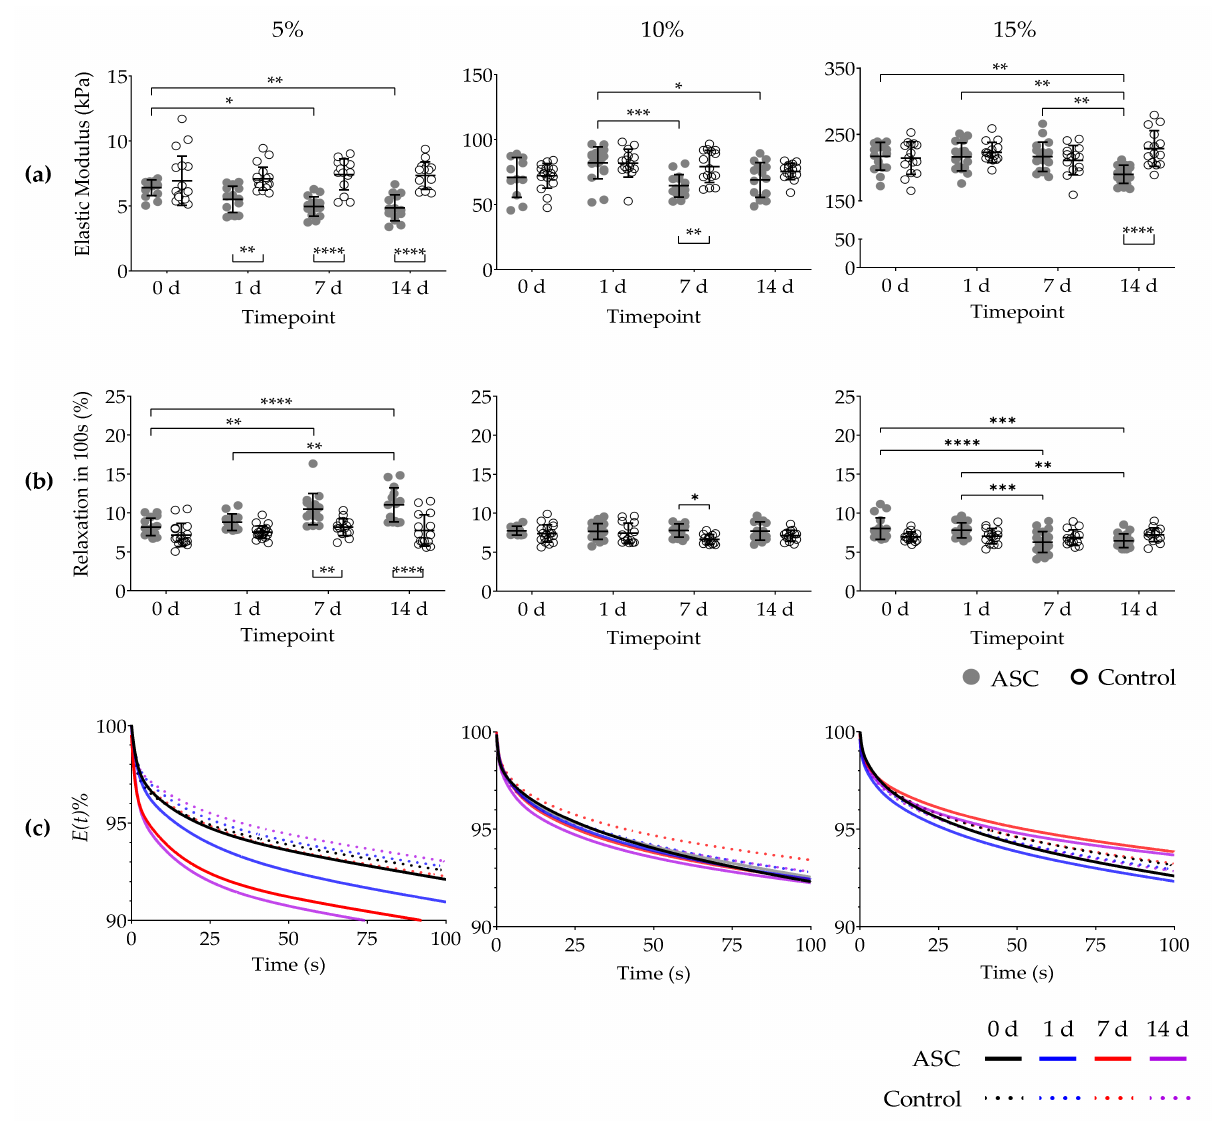
Figure 3. Elastic modulus and percentage of stress relaxation of GelMA hydrogels after 14 days in culture. ( a ) Elastic modulus of cell-loaded (ASC) and cell-free (Control) 5%, 10%, and 15% GelMA at a strain rate of 0.2 s − 1 during the first second of compression. ( b ) Percentage of stress relaxation at constant strain constant over 100 s of cell-loaded and cell-free 5%, 10%, and 15% GelMA. ( c ) Average stress relaxation normalised to start from 100% for 100 s. Data derives from a minimum of five non-paired samples per timepoint, from three independent experiments. Data are presented as mean with standard deviation. p values are indicated * p < 0.05, ** p < 0.01, *** p < 0.001 and **** p < 0.0001 according to Two-way ANOVA and